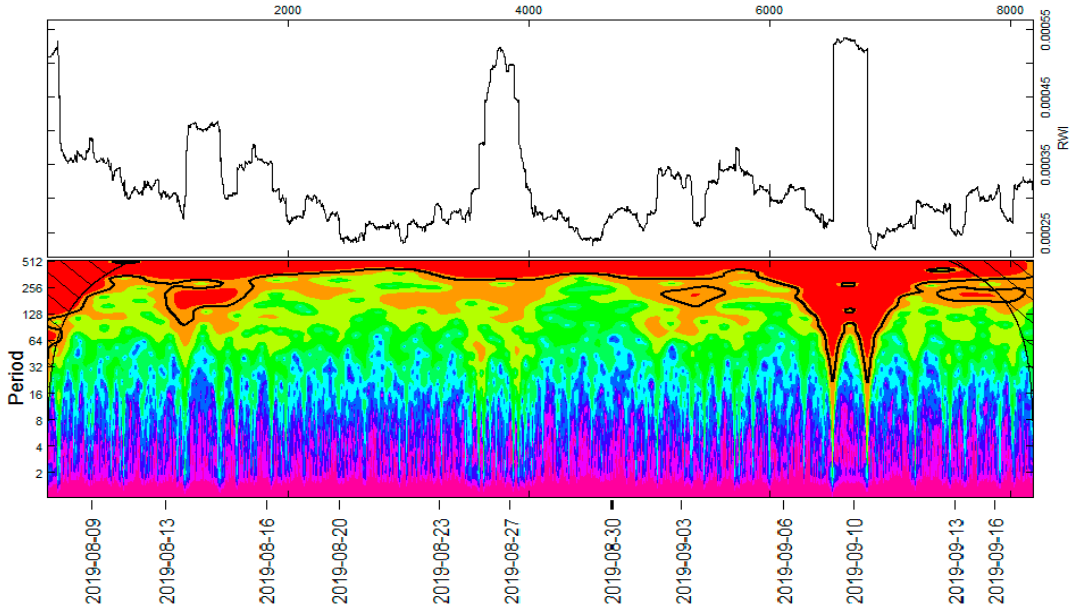
Figure 4. Wavelet heat map of five-minute nominal USD / AUD exchange rate. Notes: Horizontal axis ranges from 0 to 8193, the number of five-minute intervals in our sample. The vertical axis indicates the horizons (in five-minute) corresponding to the frequencies at which the underlying time series fluctuates. The power meter is located beneath the graph. The area within the parabolic region indicates the “zone of influence”. The plots were drawn using functions provided in the R package dplR (Bunn 2008). Source: Authors’ computations.